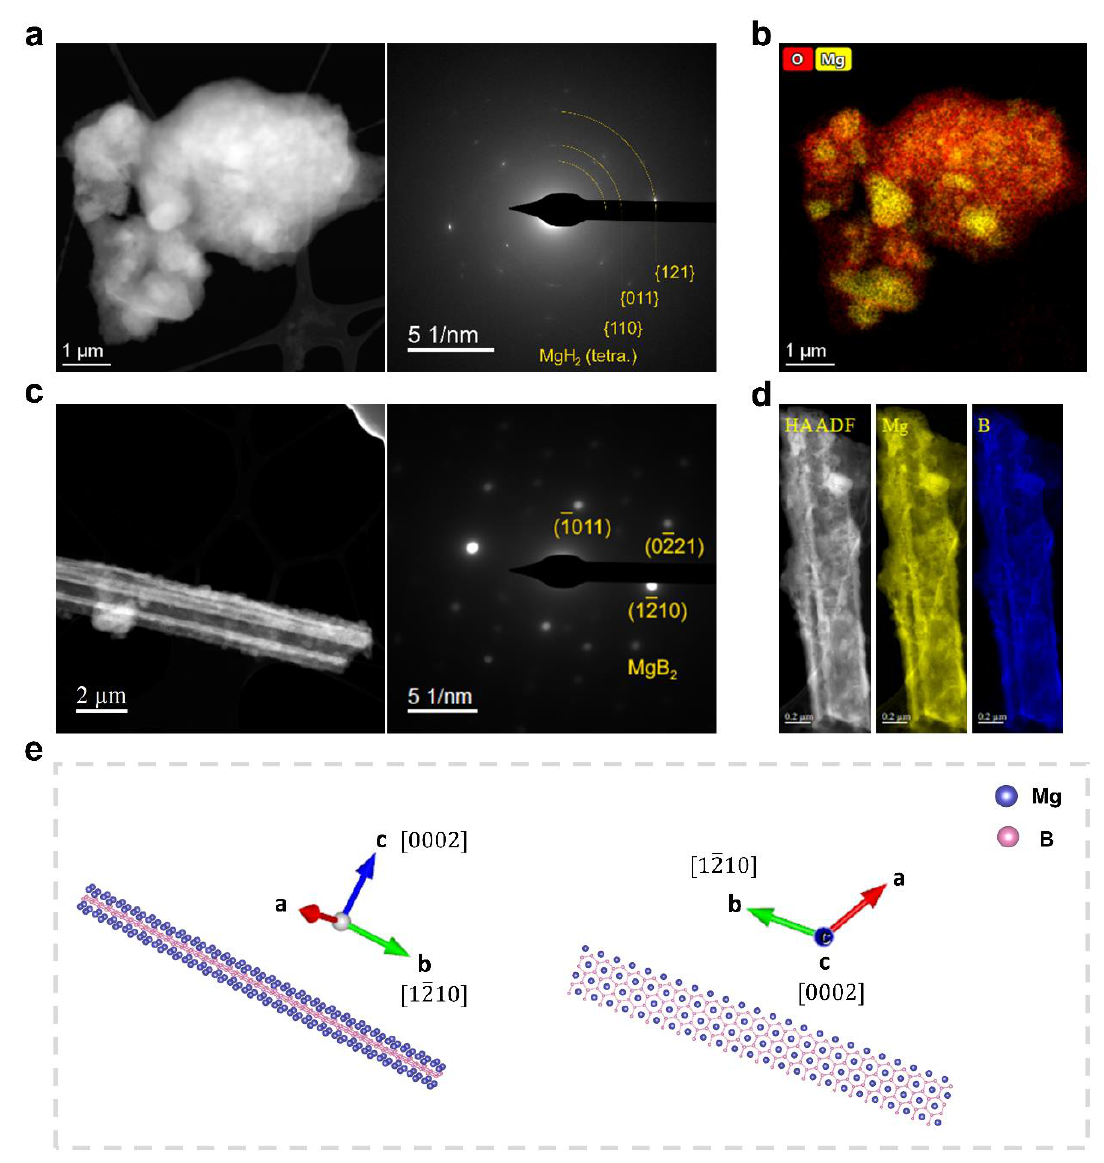
Figure 2. As-milled or desorbed 2LiBH 4 – MgH 2 without additive: ( a ) STEM-HAADF image and the corresponding DP of as-milled 2LiBH 4 – MgH 2 ; ( b ) Summed EDX elemental map that was acquired in the same position as image ( a ), comprising the elemental distribution of Mg (K lines) and O (K lines); ( c ) STEM-HAADF image and the corresponding DP of desorbed 2LiBH 4 – MgH 2 ; ( d ) EELS elemental distribution of Mg (K edge) and B (K edge) with respect to the corresponding STEM-HAADF image of desorbed 2LiBH 4 – MgH 2 shows the bar-like morphology for MgB 2 ; ( e ) Schematic illustration of the crystallographic orientations for a MgB 2 rectangular bar growing in the direction [12̅10] .